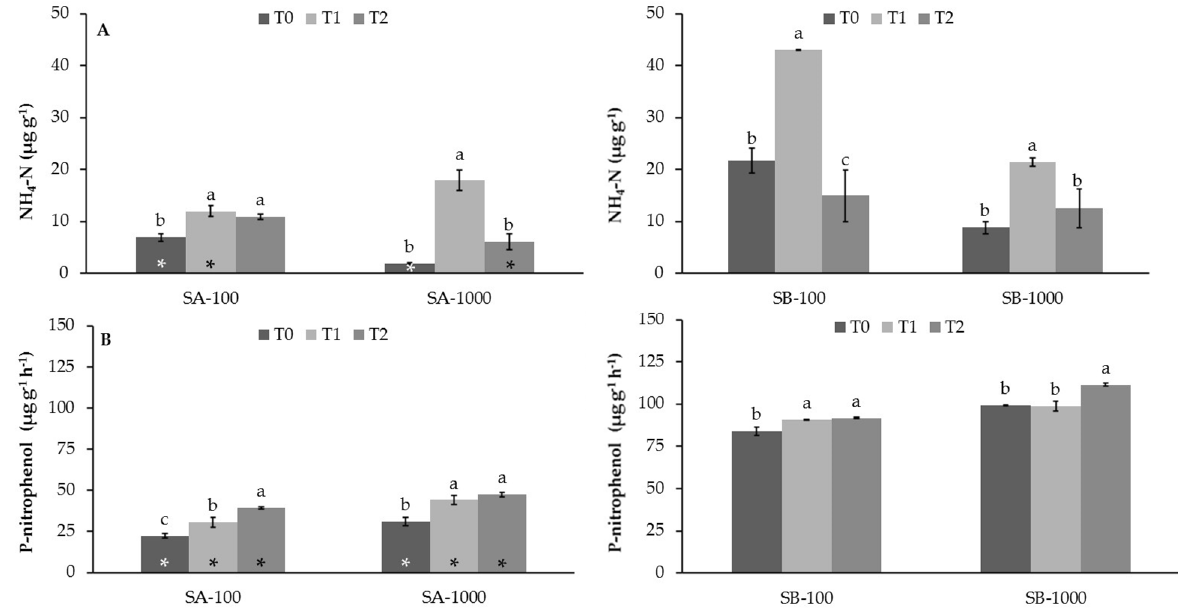
Figure 3. Urease ( A ) and β -glucosidase ( B ) activity in amended and unamended Sb-polluted SA and SB soils. Average values (histograms) and standard errors (bars) are reported. T0, T1 and T2 refer to MSWC addition, i.e., 0, 1 and 2%, respectively. For each soil (SA and SB) and Sb concentration level, different letters denote significant differences between treatments (Tukey–Kramer test; p < 0.05). For each enzyme activity, asterisks denote significant differences between SA-100 and SB-100, and between SA-1000 and SB-1000 (Student t-test; p < 0.05).